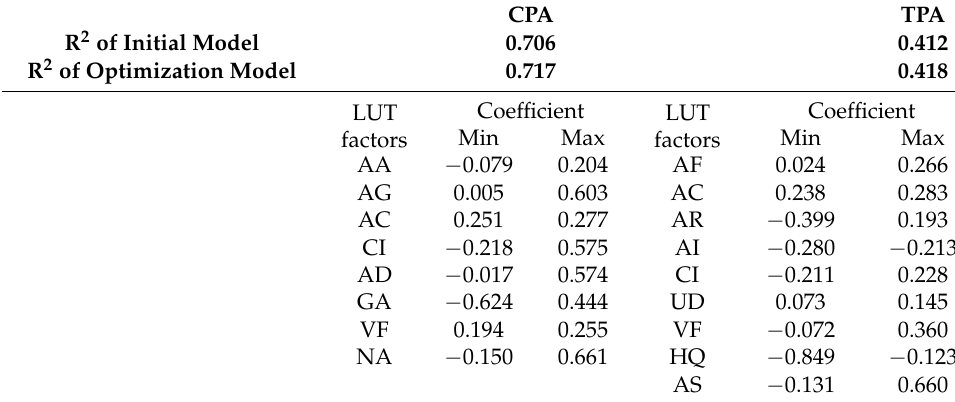
Table 4. Results of MGWR model.